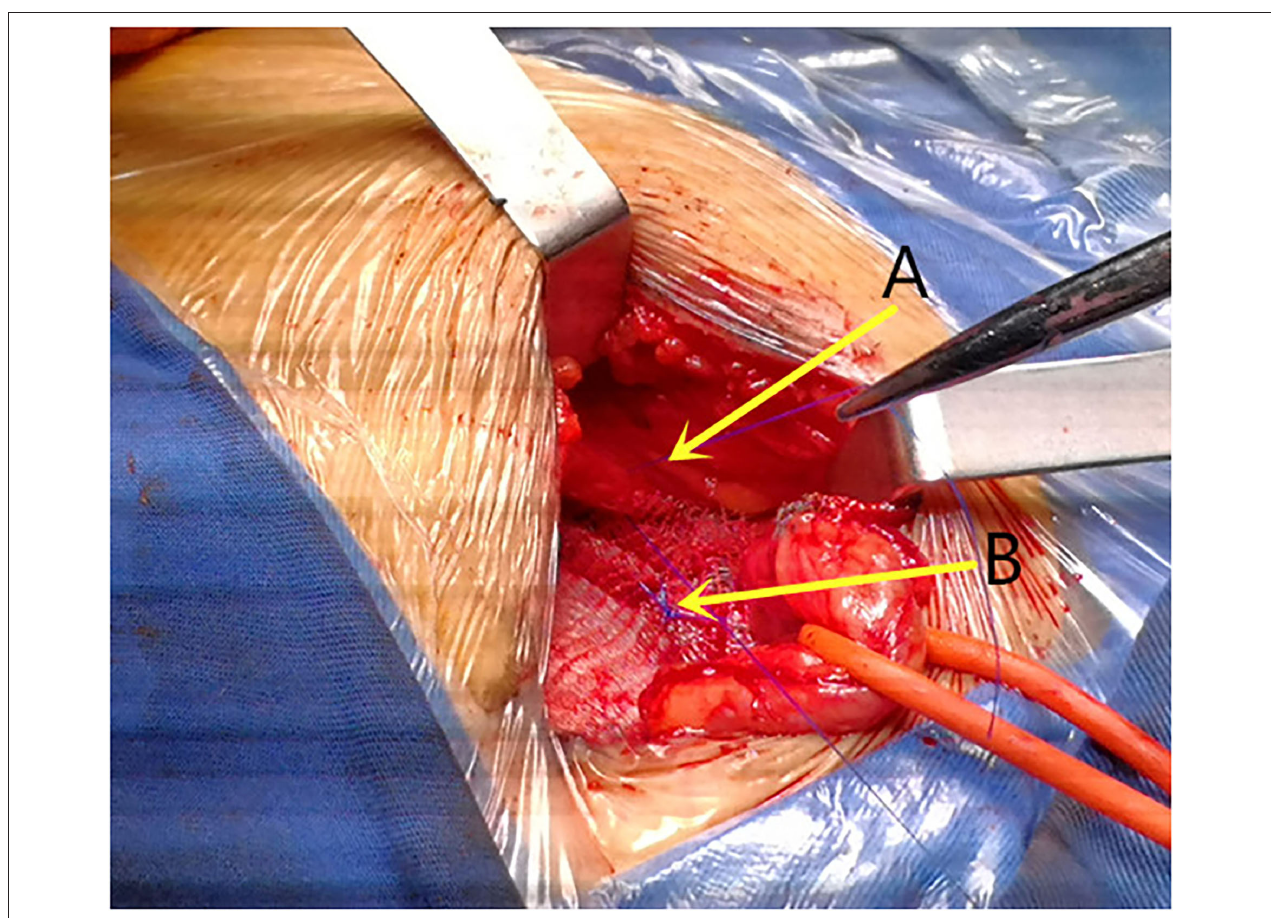
FIGURE 2 | The mesh was fixed with 2-0 prolene to the (A) posterior rectus sheath in case of large direct hernia if necessary and (B) the pubic tubercle.